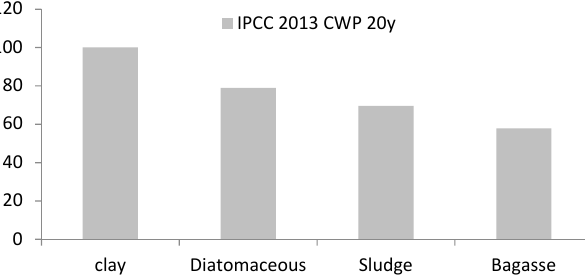
Figure 9. Carbon FootPrint, CFP of lightweight aggregates. Raw material extraction and sintering process in comparison of Clay, 15 mass% Diatomaceous earth, 15 mass% Sludge and, 15 mass% Bagasse. Sintered at 1000 °C.